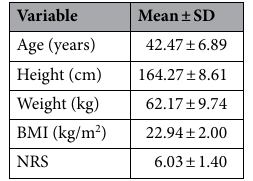
Table 1. A summary of the characteristics of all participants. BMI, body mass index; NRS, numerical rating scale.